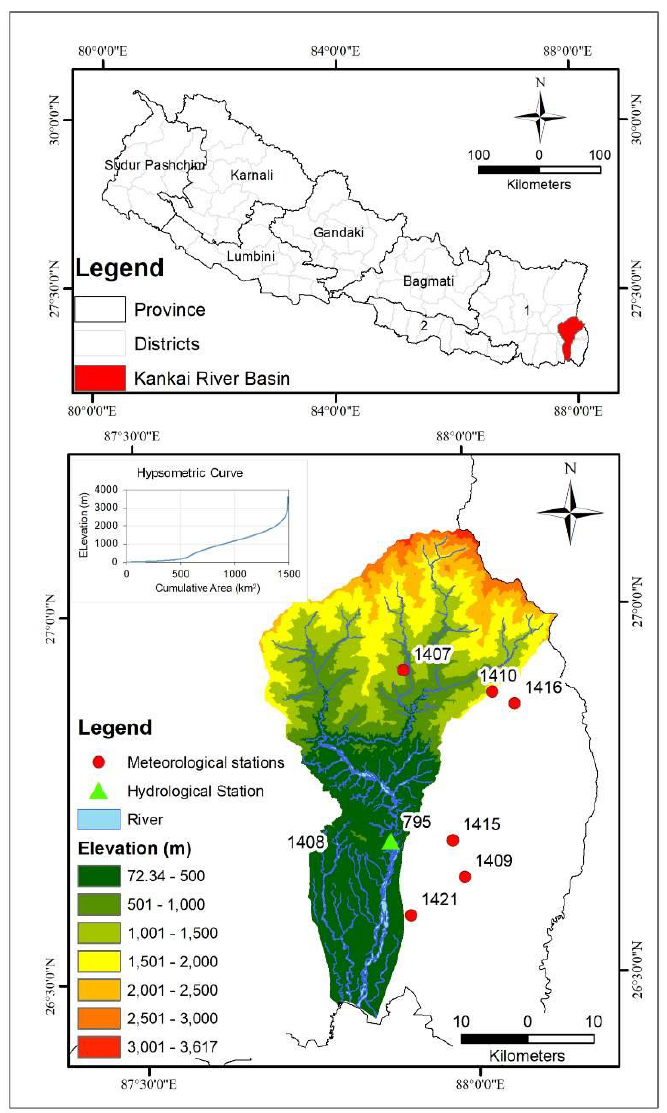
Figure 1. Location map of Kankai River Basin with elevation and distribution of hydrological and meteorological stations (the number 1 and 2 indicates the Province